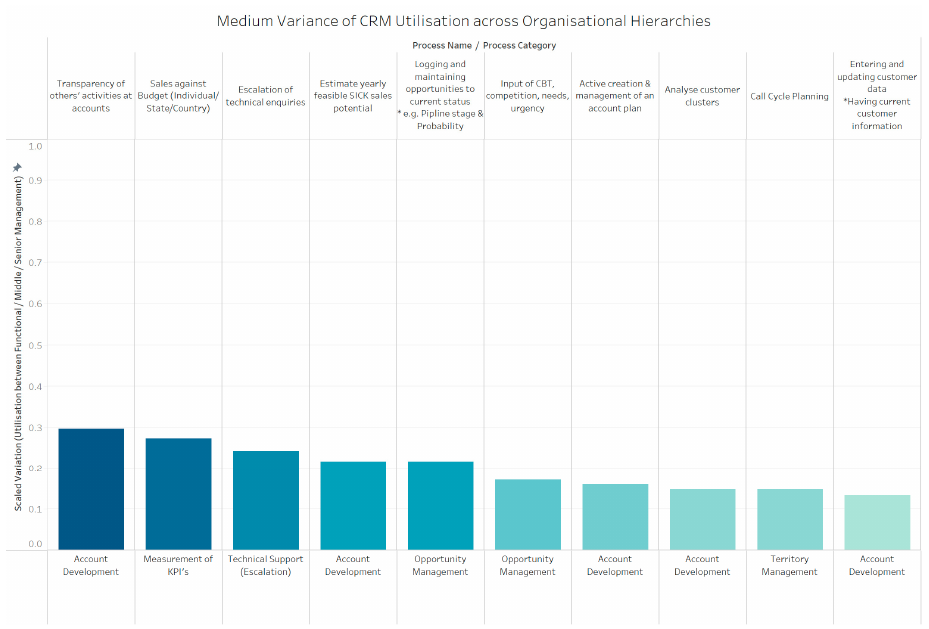
Figure 4. CRM Processes with a high variance of utilisation across organisational hierarchies, as developed for this study.